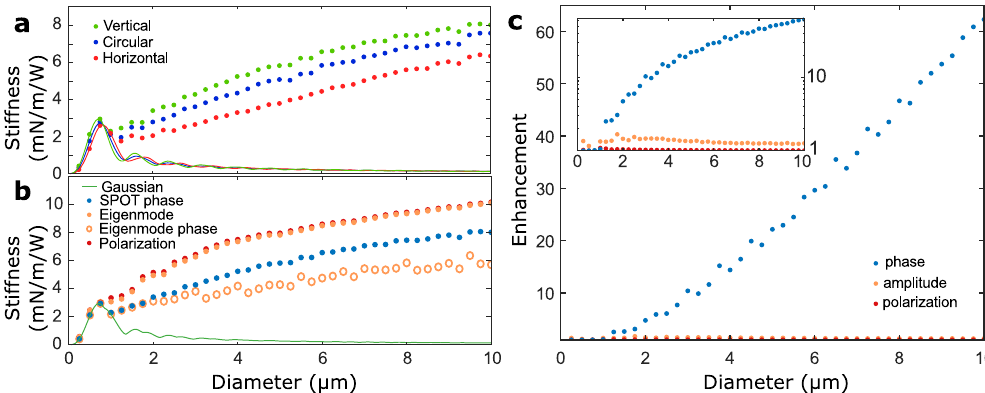
Figure 6. Size dependence. ( a ) Trap stiffness of diffraction-limited (solid lines) and SPOT (circles) trap as a function of particle diameter for silica spheres in water. The performance achieved with different polarizations can vary quite strongly, which is important when comparing different methods. ( b ) Trap stiffness as a function of diameter for Gaussian, SPOT, Eigenmode phase, full Eigenmode wavefront, and full polarization-amp-phase control. To allow fair comparison each data point corresponds to the polarization state that achieves highest stiffness. ( c ) The relative enhancement in trap stiffness that can be achieved using phase engineering, amplitude, and polarization. The inset shows this on a logarithmic scale. For particles larger than 1 μ m amplitude control offers a near-fixed enhancement with mean ± standard deviation of 1.35 ± 0.10. Polarization control offers minimal benefit, with a maximum enhancement of 1.09 at 1 μ m, dropping to 1.010 ± 0.003 above 5 μ